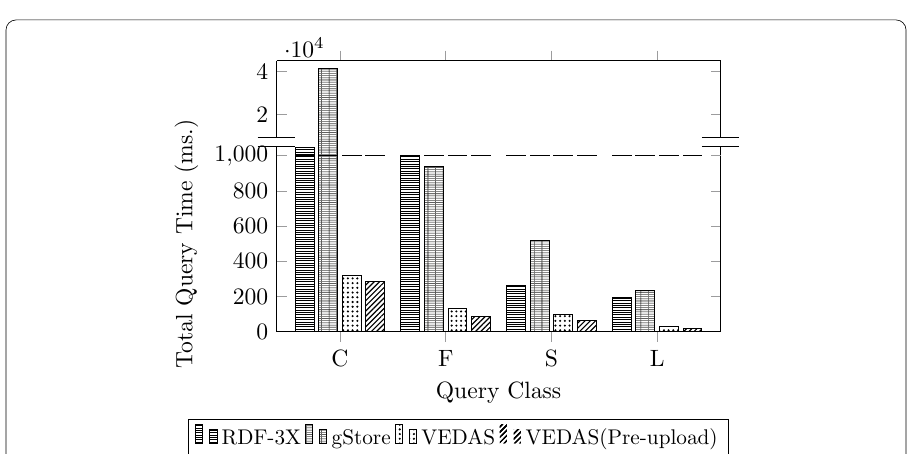
Fig. 16 Query Time for